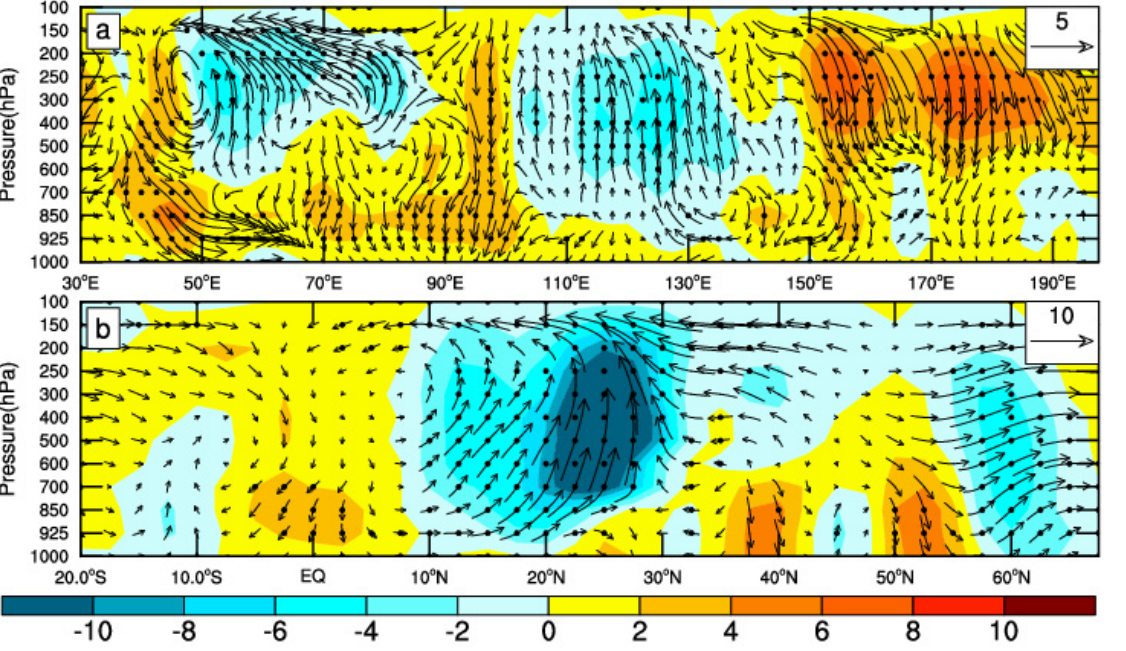
Figure 9. ( a ) Regressed anomalies of the longitude-height cross-section of the interannual component of the vertical velocity (shaded; 10 − 3 Pas − 1 ), wind (vector; meridional component, ms − 1 , multiplied by 10; vertical component, Pas − 1 , multiplied by − 1000) averaged over 5 ◦ S–5 ◦ N onto the interannual component of PC1 for the period of 1960 to 2018. ( b ) As in ( a ), but for the latitude-height cross- section and averaged over 90 ◦ − 105 ◦ E. The black spots denote the values have passed the 95% confidence